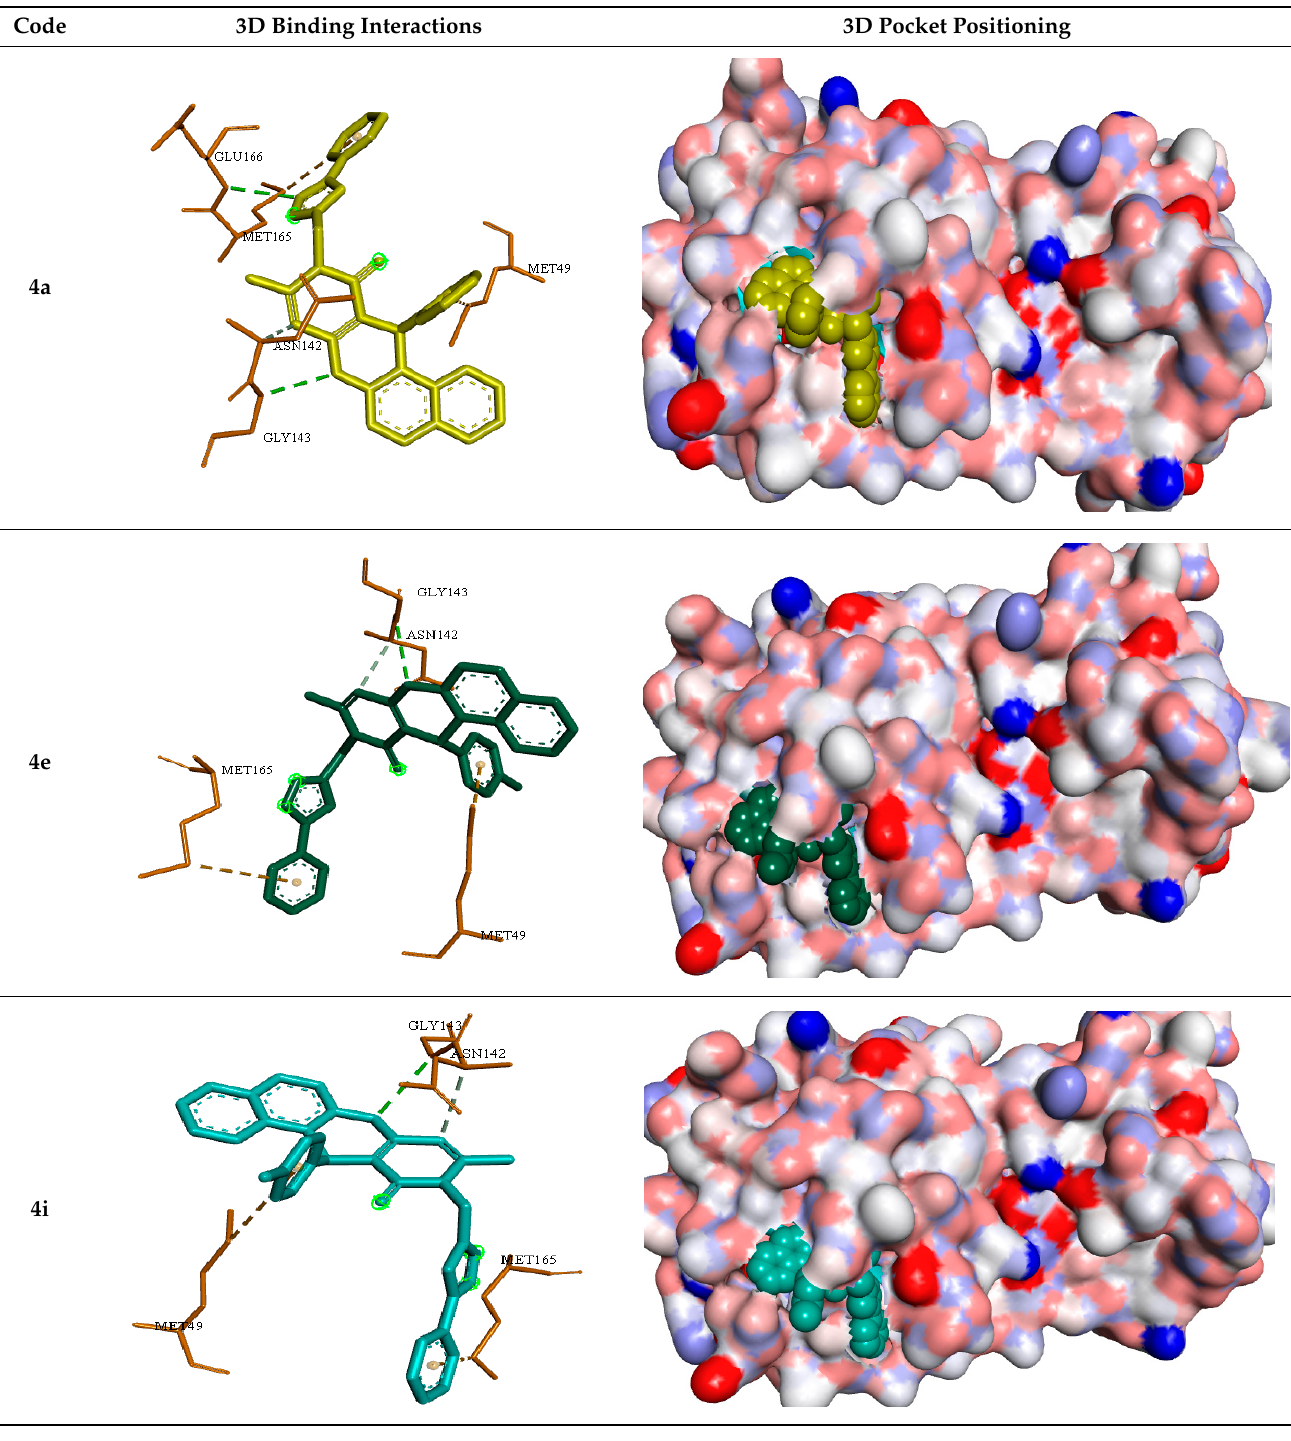
Table 3. 3D representations showing the binding interactions and positioning between the three promising tested com- pounds ( 4a , 4e and 4i ) and the N3-binding pocket in comparison to the docked N3 inhibitor. Code 3D Binding Interactions